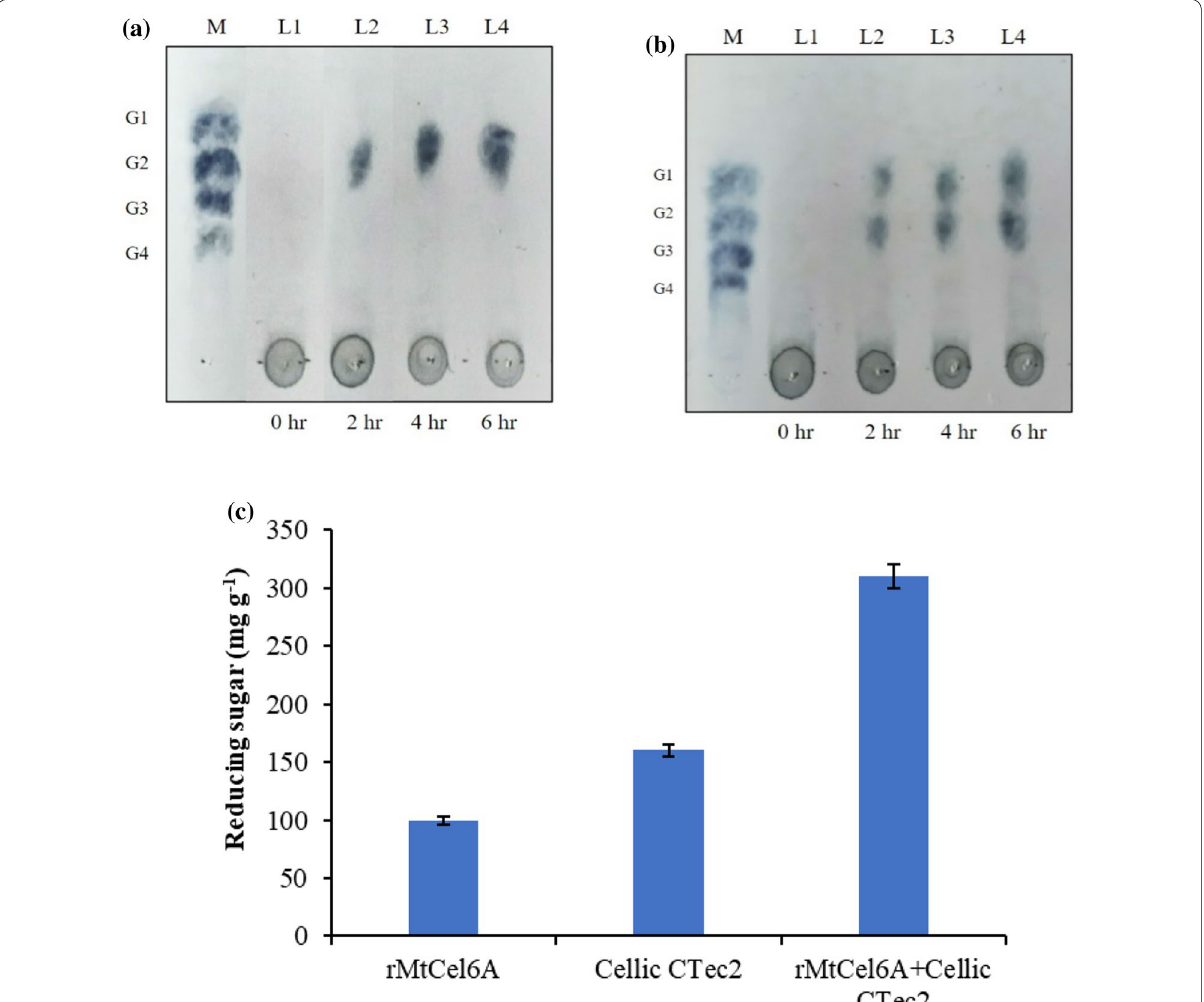
Fig. 6 End product analysis of sugarcane bagasse hydrolysis by TLC; where M shows sugar standards and L1-L4 show the hydrolytic products